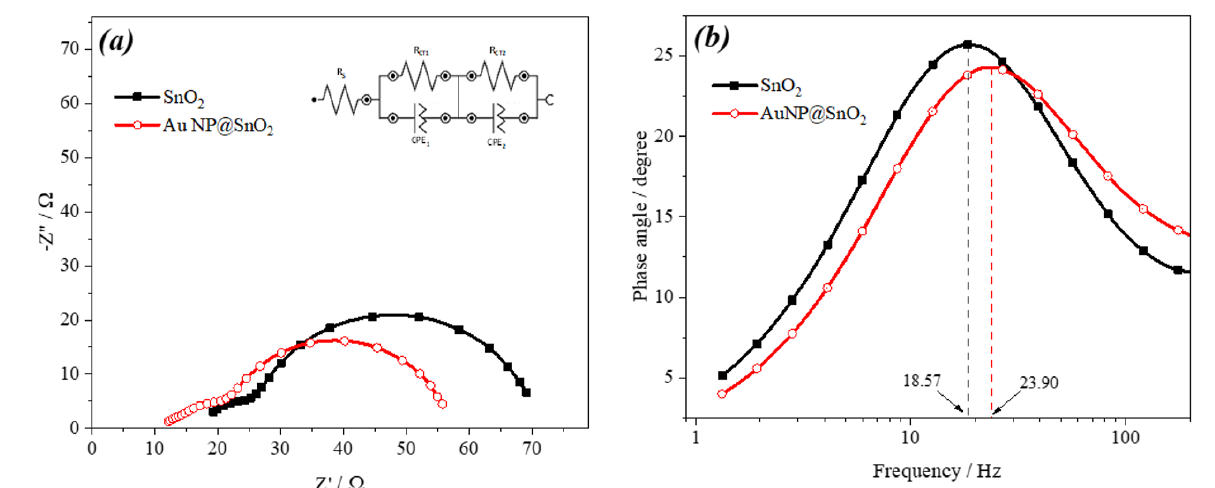
Figure 4 : (a) Nyquistic plots and (b) Bode phase plots for optimized DSSCs made with bare SnO